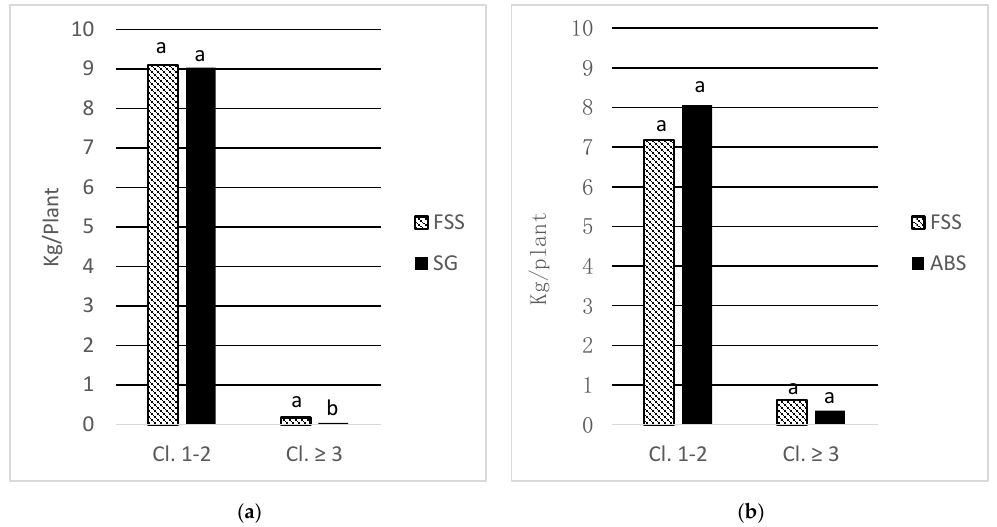
Figure 5. Grape yield in Vidor ( a ) and Soave ( b ) vineyards calculated as kg/plant of vines harvested. Class 1–2 bunches were 1st quality bunches (portion of bunch damaged < 5%); class ≥ 3 bunches were 2nd quality bunches (portion of bunch damaged ≥ 5%). Different letters within each class indicate significant statistical differences.